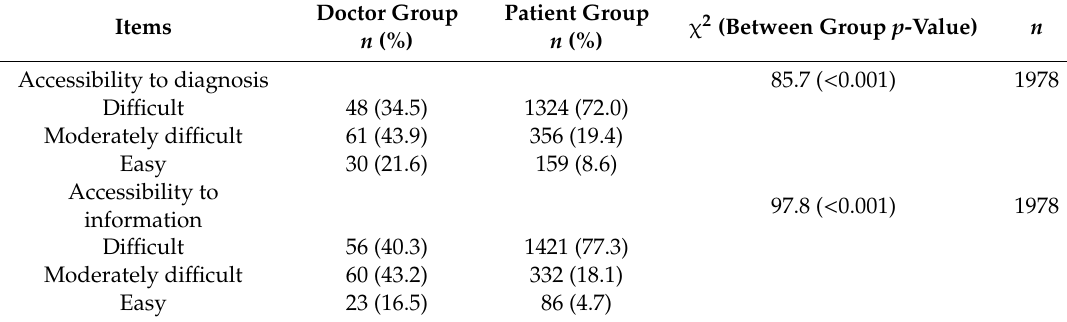
Table 2. Perceptions on accessibility to diagnosis of and information on rare diseases between groups.